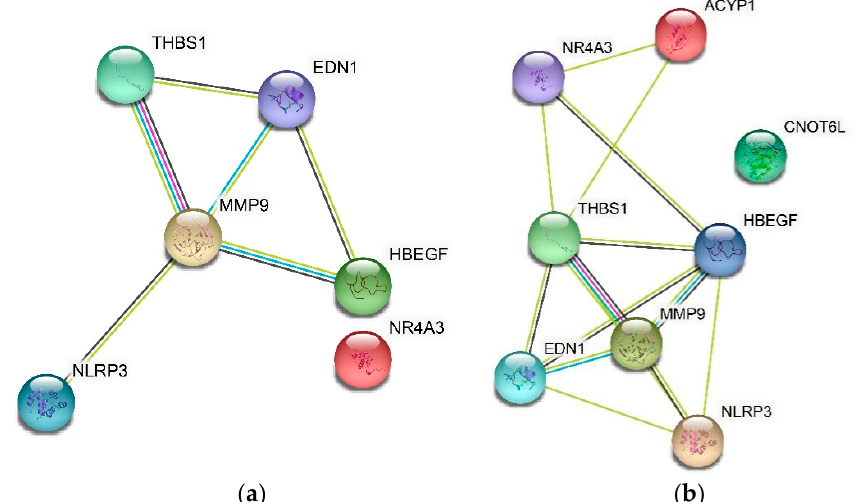
Figure 7. ( a ) HBEGF , THBS1 , NR4A3 , NLRP3 , EDN1 , MMP9 interaction network at the 0.4 threshold. ( b ) HBEGF , THBS1 , NR4A3 , NLRP3 , EDN1 , MMP9 , ACYP1 , CNOT6L interaction network at the 0.15 threshold.